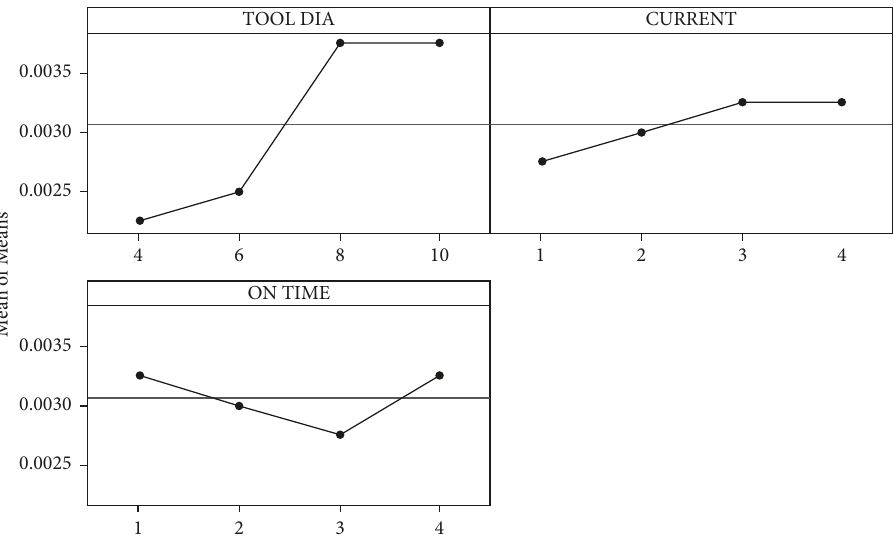
Figure 11: Main effect plot for means (ANOVA method).